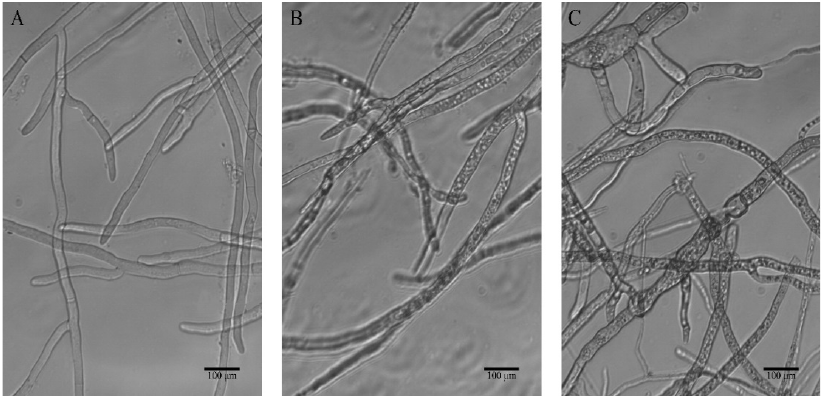
Figure 3. Effect of different concentrations of compound 3c on the hyphal morphology of B. cinerea strains observed by a light microscope (×200), ( A ) blank control, ( B ) 100 µg/mL, ( C ) 200 µg/mL. Cell membrane plays a pivotal role in maintaining cellular basic metabolism and de- fending the cell against exogenous disturbance [36]. Electrolyte leakage is generally taken as an indicator of cell membrane permeability. Hence, in order to confirm whether com- pound 3c affects the membrane permeability of B. cinerea , the electrical conductivity of suspensions of intact mycelia was measured. Compared to the control group, the relative permeability in the 3c -treated groups was higher and continually elevated during the en- tire time of treatment, even 25 h later (Figure 4). Besides, the extent of the damage induced by 3c to the mycelial cell membrane system increased in a concentration-dependent man- ner, which was distinctly revealed by significant effects at 200 µg/mL within 10 h. These findings proved that the exposure to compound 3c permeabilized the membrane, led to electrolyte leakage and thereby augmented the conductivity of the solution.